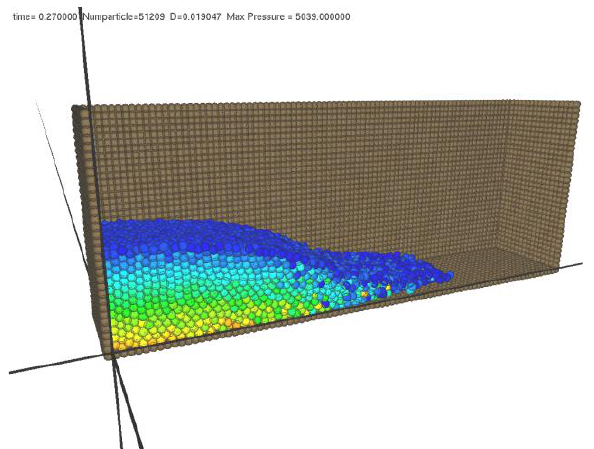
Fig. 13(b). Bird's eye view of dam break simulation (t = 0.27 sec.) .